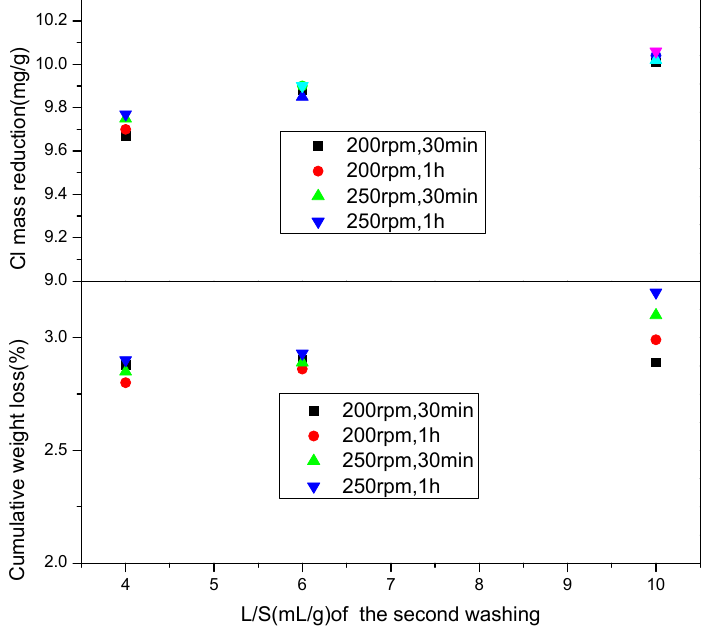
Figure 4. Chlorine mass reduction and cumulative weight loss of APC residue.